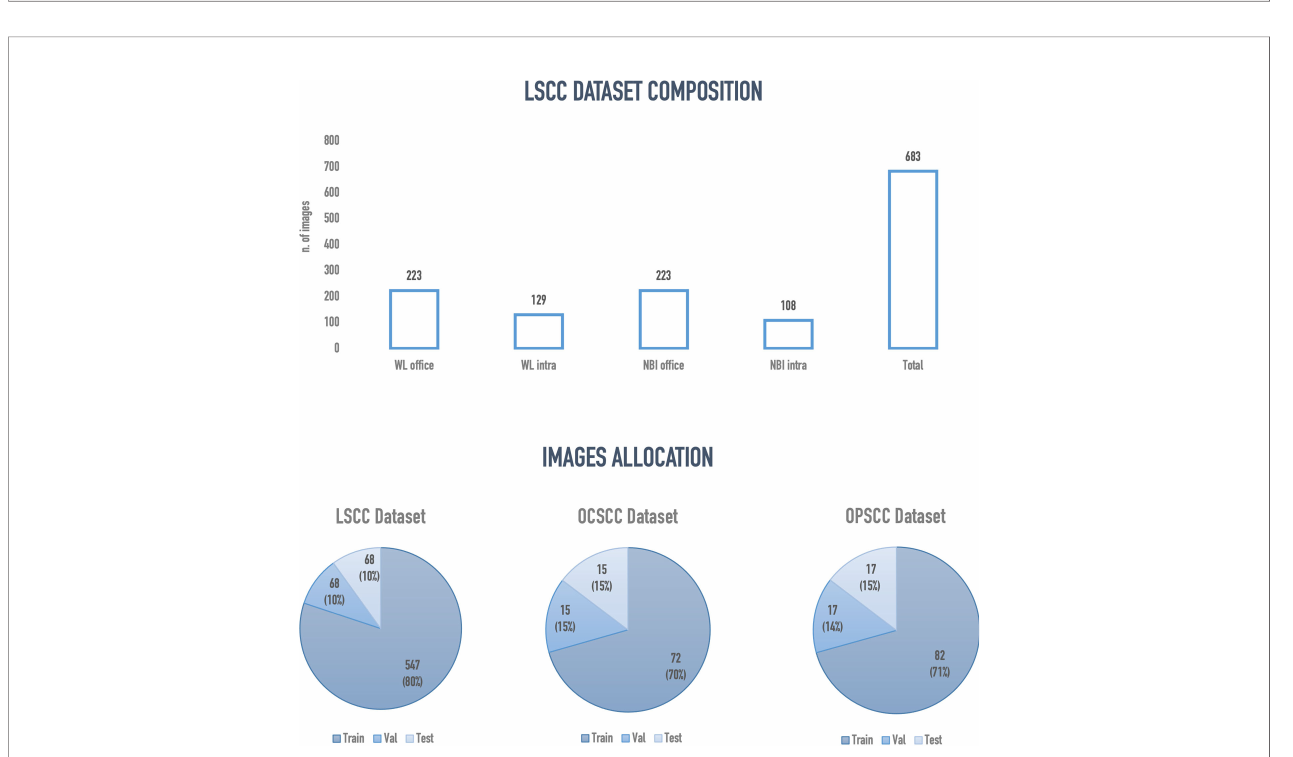
FIGURE 5 | Overview of the fi nal con fi guration of laryngeal squamous cell carcinoma (LSCC), oral cavity squamous cell carcinoma (OCSCC) and oropharyngeal squamous cell carcinoma (OPSCC) dataset. Val, validation; WL, white light; NBI, narrow band imaging; Intra, intraoperative endoscopy acquired image; Of fi ce, inof fi ce endoscopy acquired